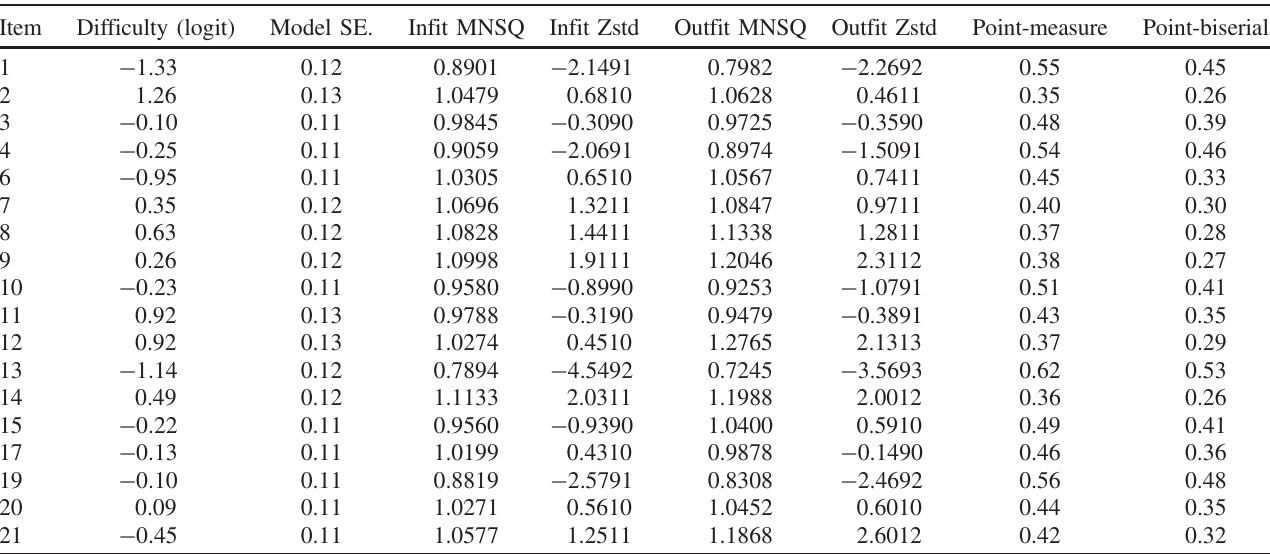
TABLE II. Rasch analysis statistics of the questionnaire.